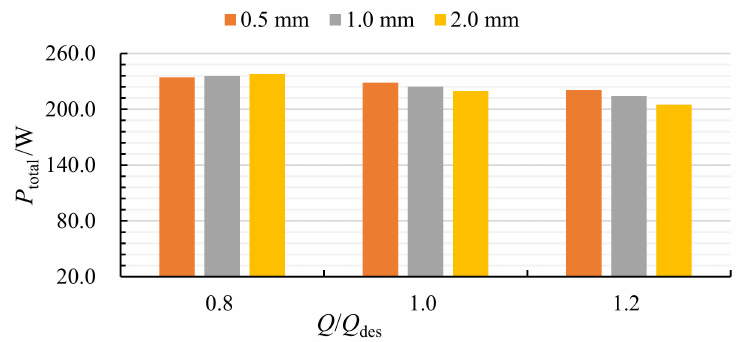
Figure 9. Total dissipation of different backflow